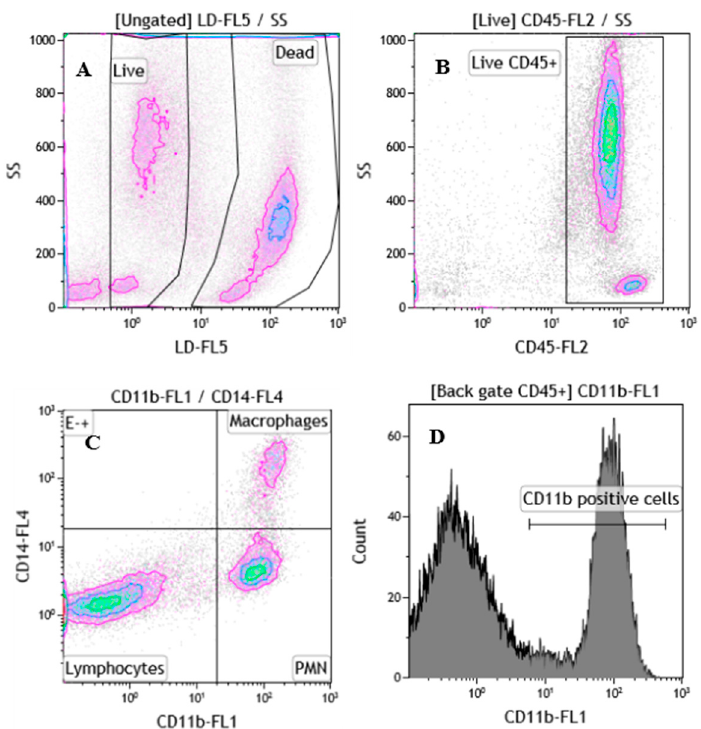
Figure 1. Gating strategy for milk leukocytes subsets identification and CD11b expression. ( A ) Identification of viable milk cells as live / dead negative (LD − ); ( B ) within live gate, identification of milk leukocytes as CD45 + cells; ( C ) identification of live lymphocytes, macrophages and PMN cells; ( D ) histogram showing the CD11b expression on CD45 + cells, calculated as mean fluorescent intensity (MFI).